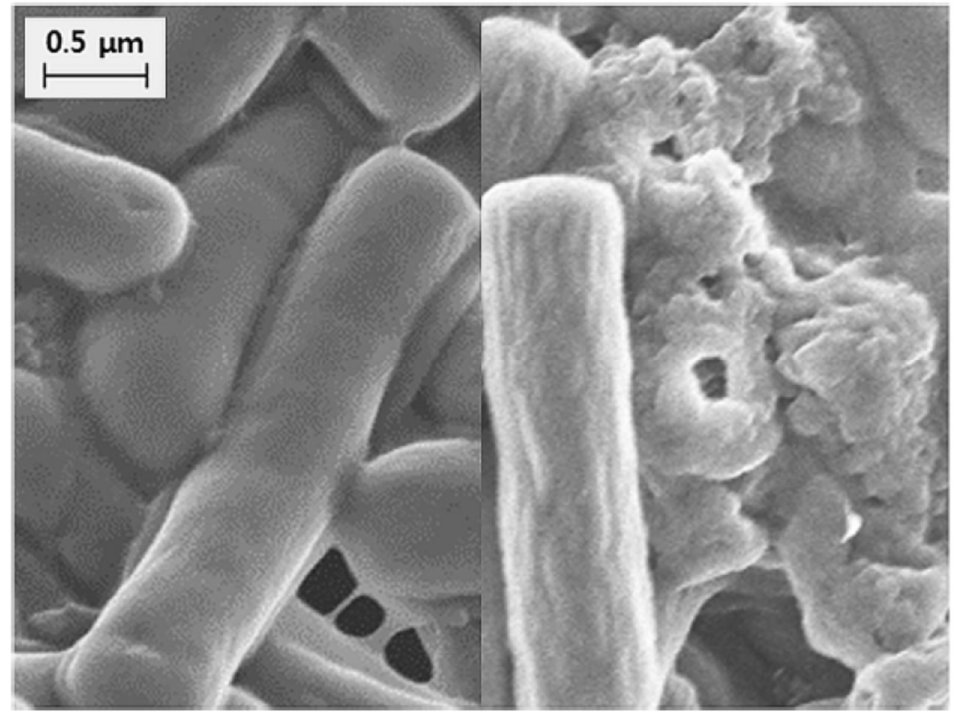
Figure 2. Comparison with non-treated (left panel) and tyndallized L. rhamnosus (right panel) [85].